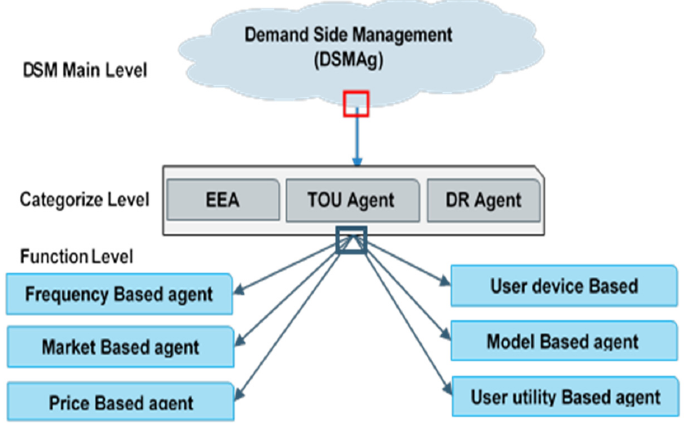
Figure A1. Demand Side Management Level.